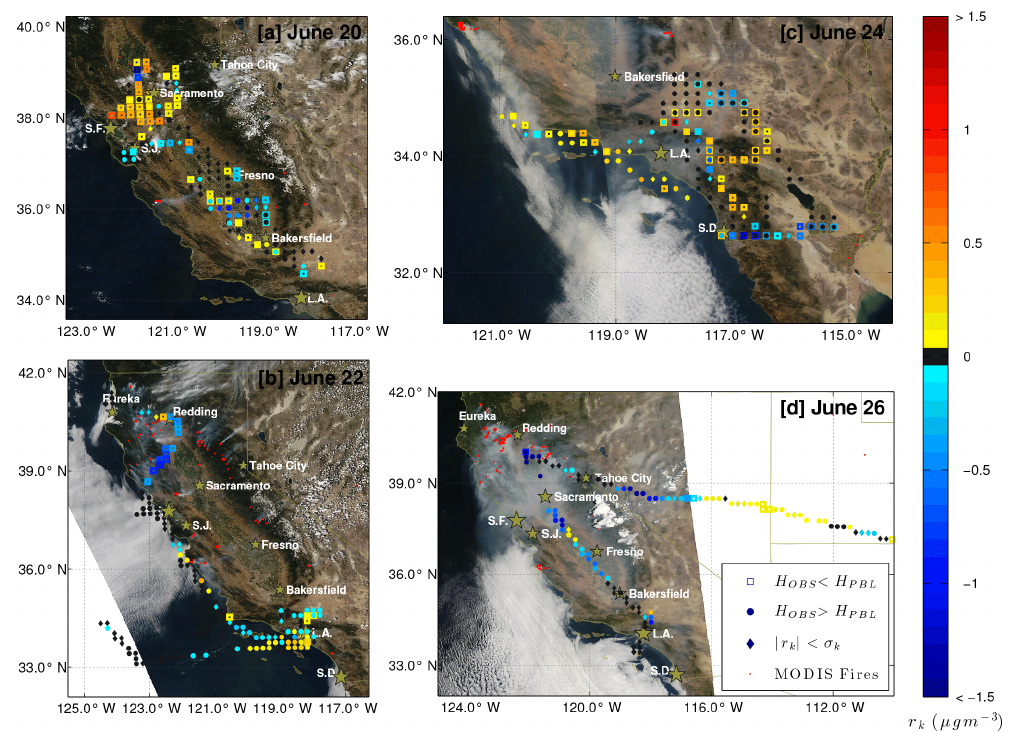
Figure 6. Aircraft residual model error, r k , with indication for the observation height relative to the model PBL height overlaid on MODIS Aqua true color images and active fire retrievals. Observations with a bias less than 1SD are also